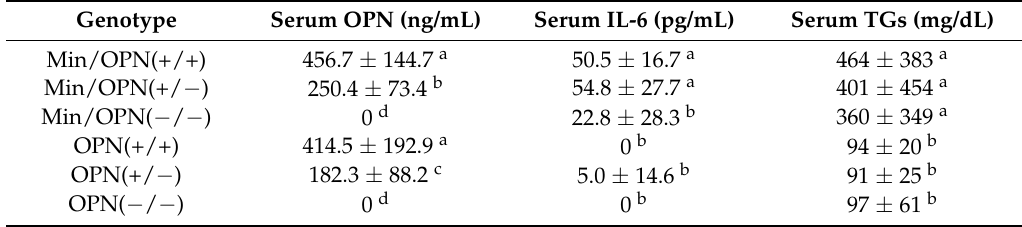
Table 3. Effects of OPN deficiency on serum levels of OPN, interleukin (IL)-6, and triglycerides (TGs). Genotype Serum OPN (ng/mL) Serum IL-6 (pg/mL) Serum TGs (mg/dL)